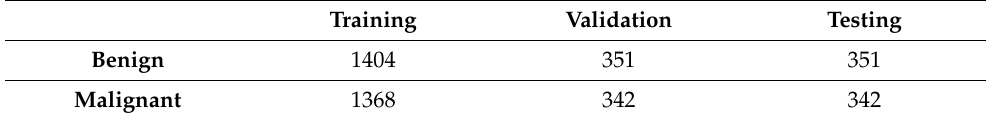
Table 2. Data division. Number of planar images used for training, validation, and testing.